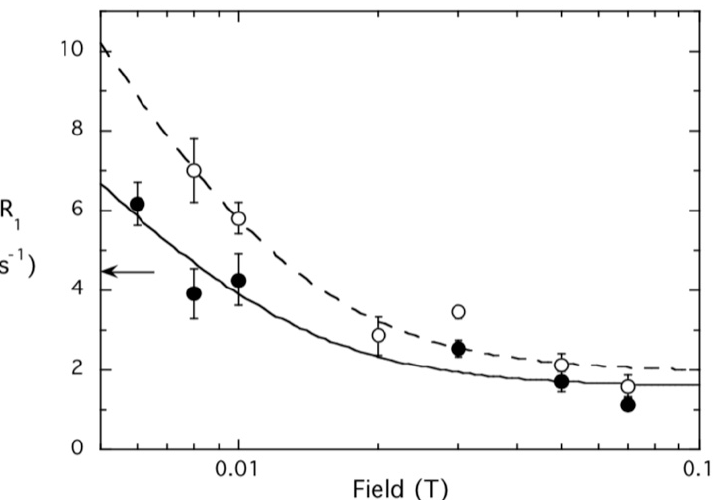
Figure 11. The R D0 region for the DOPMe 31 P in SUVs of POPC/DOPMe (5 mM:5 mM) in the presence of 0.014 mM (filled circles) and 0.029 mM (open circles) spin-labeled Bt -PI-PLC H82C. The arrow indicates R D0 (0) extrapolated to zero field for the SUVs with unlabeled Bt PI-PLC.